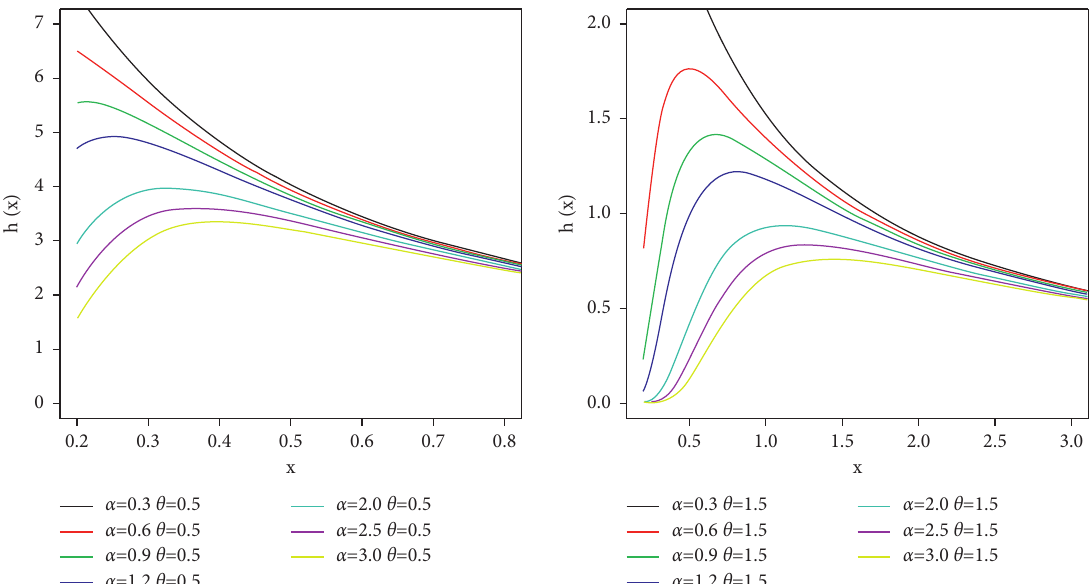
Figure 3: The hrf of the TLIL distribution for different values of